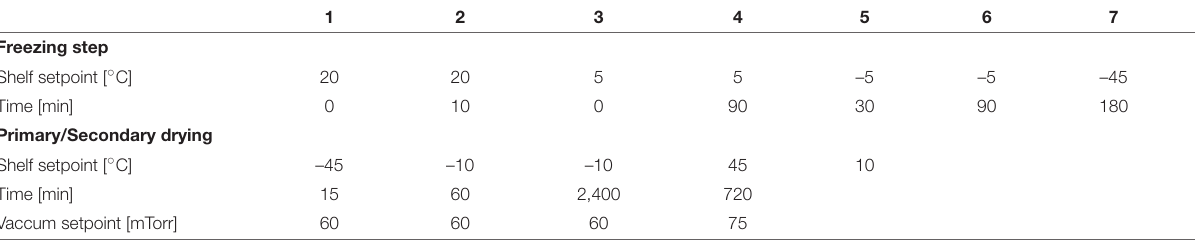
TABLE 6 | Freeze drying recipe used for 5% w/v sucrose solution.